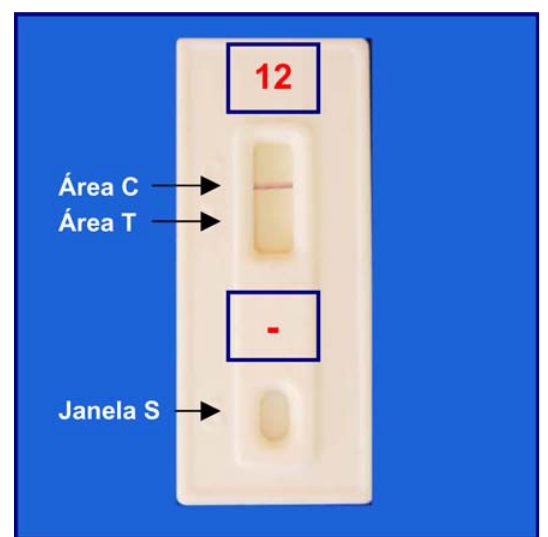
FIGURA 3 - Dispositivo imunocromatográfico com reação negativa para Helicobacter pylori no cão 12. A negatividade é observada pela ausência de coloração na área T (teste) do